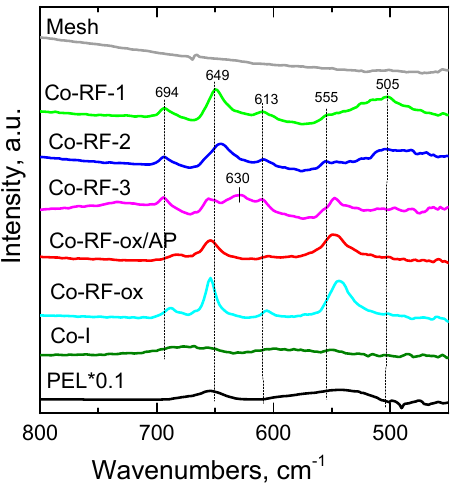
Figure 3. FTIR spectra of the examined cobalt oxides catalysts.